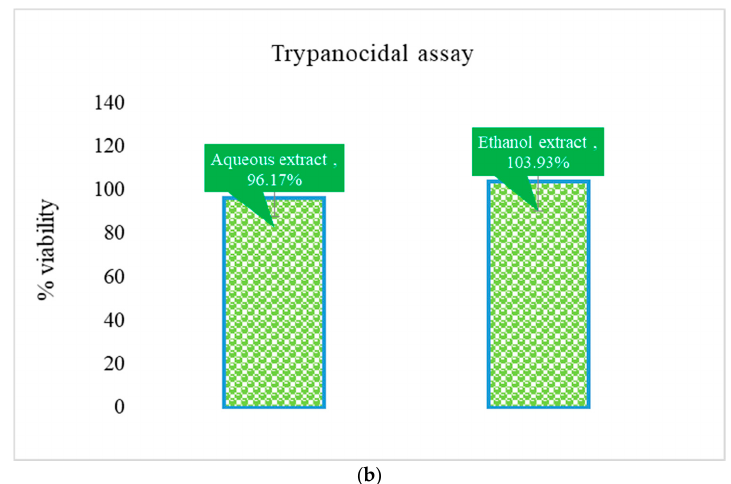
Figure 3. ( a ) Pentamidine standard @ IC 50 ~ 0.014 µM; ( b ) % viability of Trypanosoma brucei culture with water and ethanol extracts.